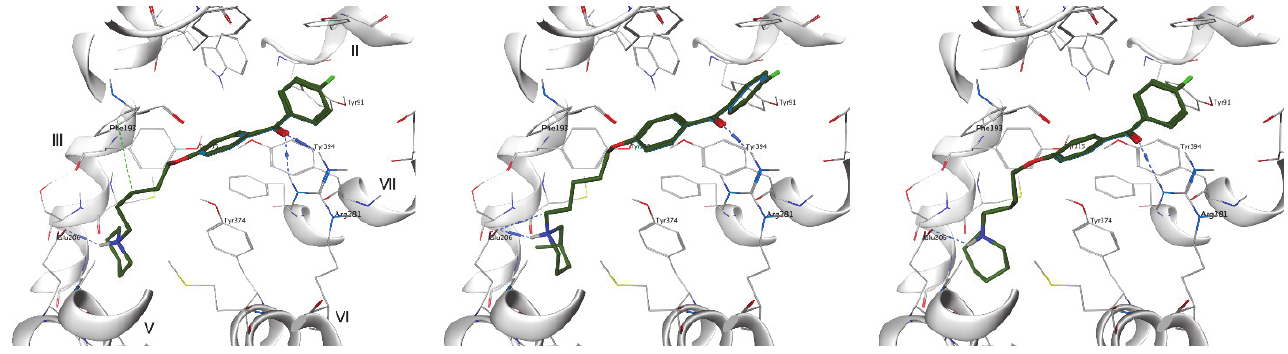
Figure 5 . Putative binding modes of 6 ( left ), 16 ( middle ) and 30 ( right ) in histamine H 3 R binding site. Blue dashed lines express hydrogen bonds, green cation – π interactions; roman numbers denote TMs.